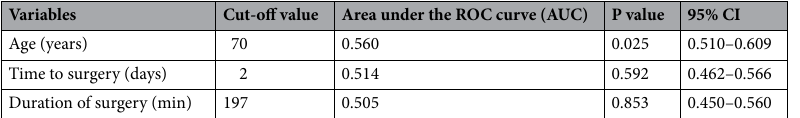
Table 1. Optimum cut-off value of continuous variables detected by the ROC analysis. ROC receiver- operating characteristic, CI confidence interval.